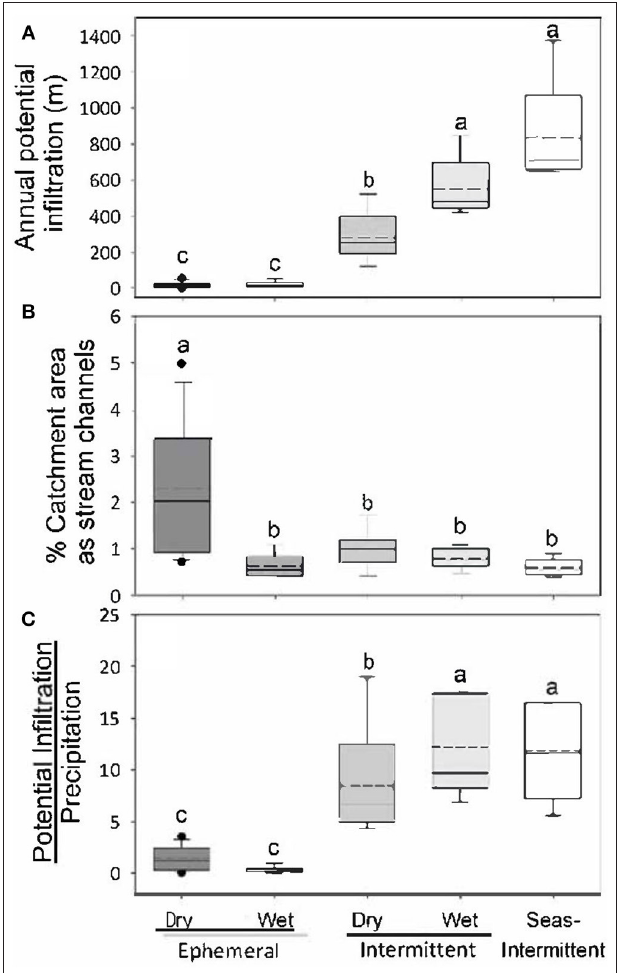
FIGURE 9 | (A) Observed annual streamflow (this study) vs. modeled annual streamflow from Levick et al. (2018) and (B) Observed annual water presence (this study) vs. modeled annual streamflow from Levick et al.